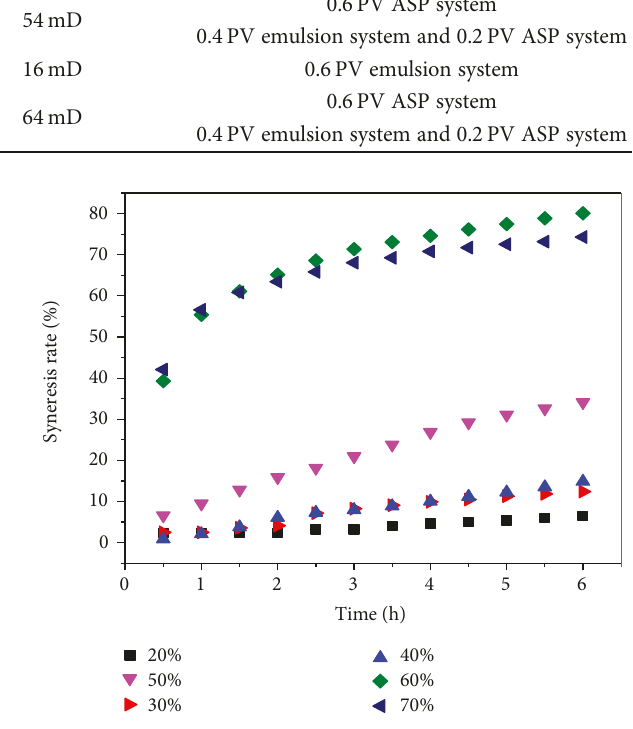
Figure 3: Emulsion viscosity change curve under di ff erent water